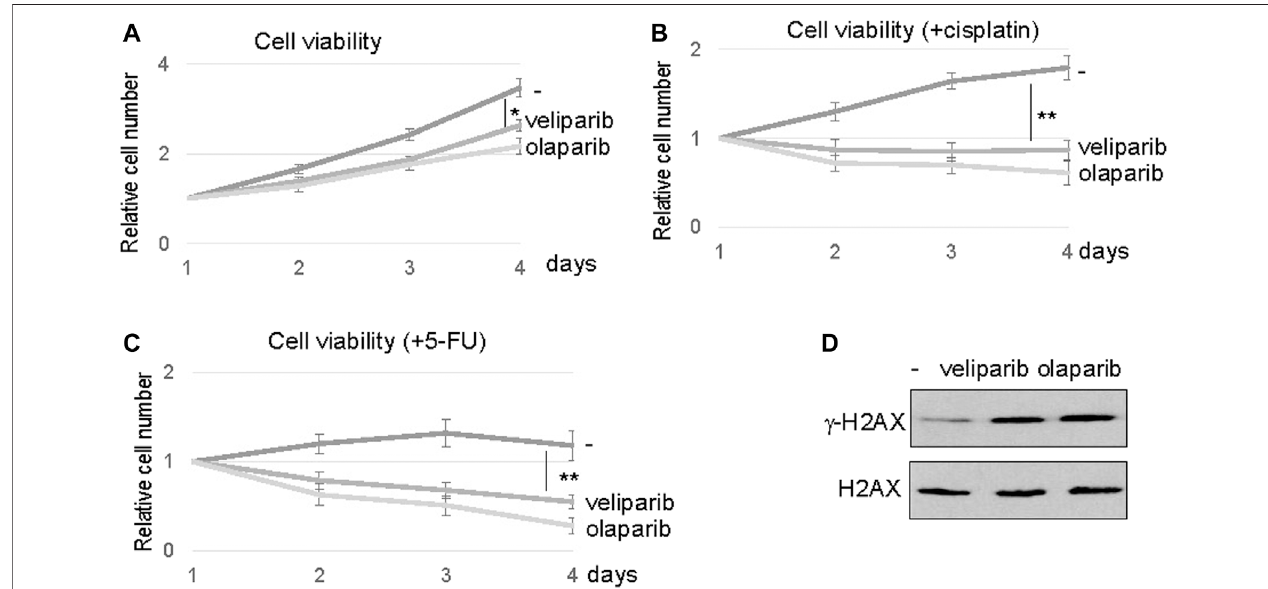
FIGURE 5 | PARP inhibition sensitized SCC11B cells to DNA damage. (A) SCC11B cells were incubated for 4 days, with or without veliparib and olaparib, as indicated. The cell numbers at days 2 – 4 were normalized to that at day 1 (untreated). The mean values and standard derivations, from three independent experiments, wereshown. (B) SCC11Bcellswereincubatedfor4 days,withorwithoutveliparibandolaparib,asindicated.Cisplatin(10 μ M)wasaddedatday1.Thecellnumbersat days 2 – 4 were normalized to that at day 1 (untreated). The mean values and standard derivations, from three independent experiments, were shown. (C) SCC11B cells were incubated for 4 days, with or without veliparib and olaparib, as indicated. 5-FU (10 μ M) was added at day 1. The cell numbers at days 2 – 4 were normalized to that at day 1 (untreated). The mean values and standard derivations, from three independent experiments, were shown. (D) SCC11B cells were treated with or without veliparib and olaparib for 1 day. The cells were harvested and analyzed by immunoblotting for c -H2AX and H2AX.